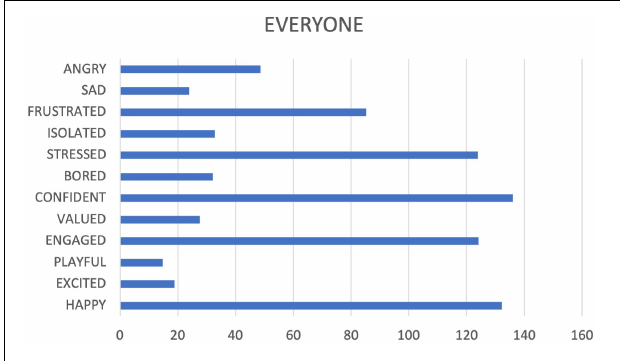
FIGURE 3 | Cumulative frequencies of all participant’s data input.